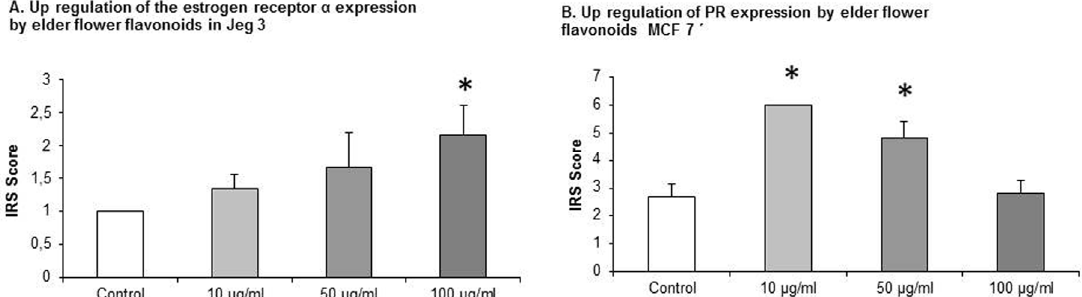
Figure 3. Upregulation of ER α and progesterone receptor by elder flower flavonoids in JEG ‐ 3 and MCF7 cells. The effective EFE concentrations were 10 μ g/mL, 50 μ g/mL, and 100 μ g/mL. Significantly different observations are highlighted with an asterisk.